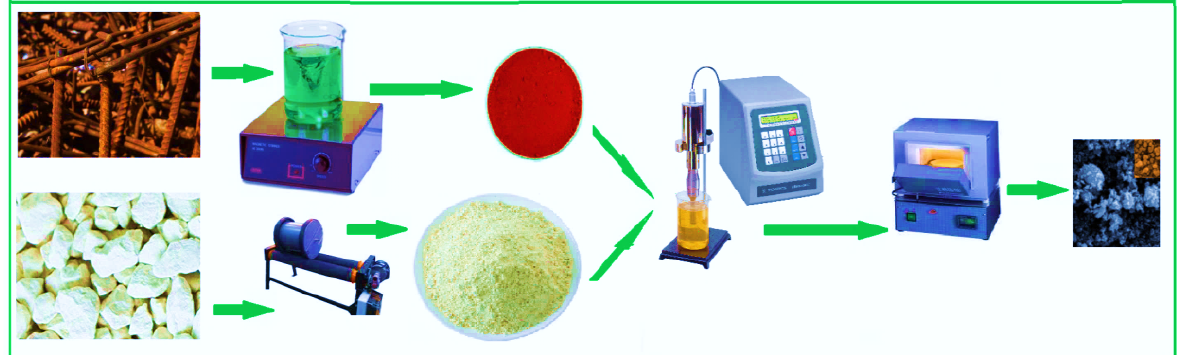
Figure 1. Schematic of the synthesis steps of Fe 2 O 3 /zeolite.